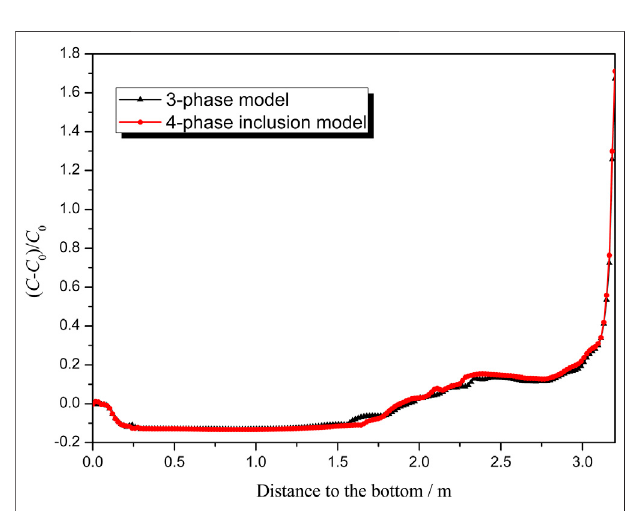
FIGURE 7 | Comparison of segregation index along the centerline of the ingot between the simulation results of the three-phase model and the four- phase inclusion